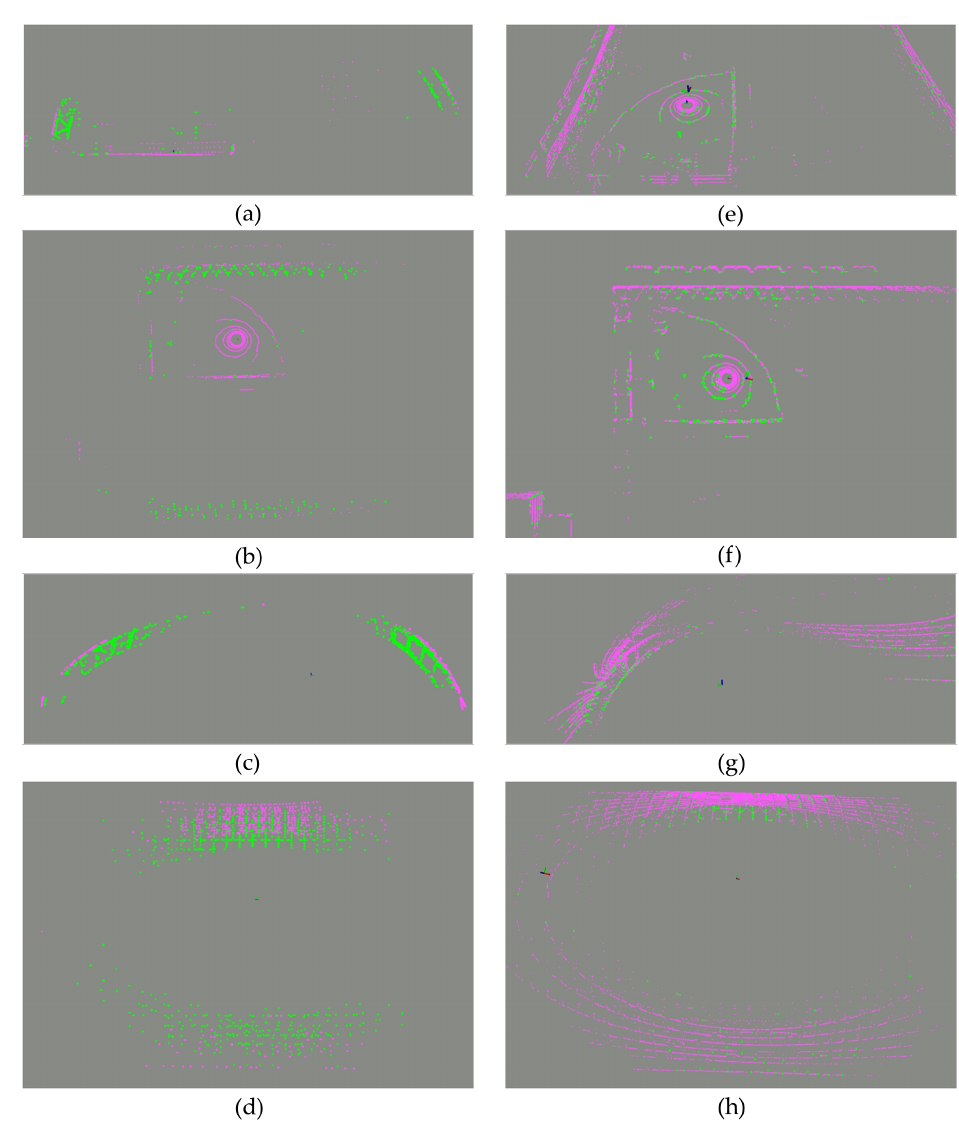
Figure 8. The features extracted by the proposed algorithm and LOAM algorithm. ( a , b ) are the features extracted by the proposed algorithm for the low-altitude take-off and landing stage of the UAV operations. ( c , d ) are the features extracted by the proposed algorithm for the high-altitude cruise stage of the UAV operations. In ( a – d ), we marked the shell feature in pink and the grid feature in green. ( e , f ) are the features extracted by the LOAM algorithm for the low-altitude take-off and landing stage of the UAV operations. ( g , h ) are the features extracted by the LOAM algorithm for the high-altitude cruise stage of the UAV operations. In ( e – h ), we marked plane features in pink and line features in